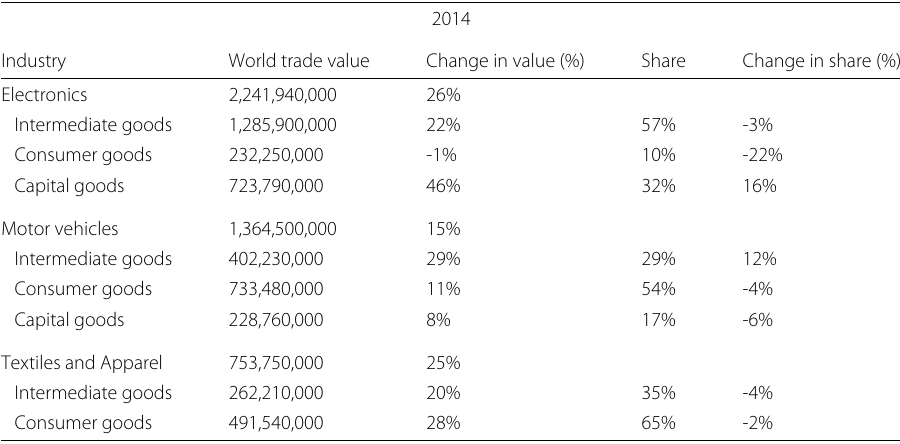
Table 2 USD values (current prices), share, and rate of variation of intermediate, consumer, and capital goods in the Electronics, Motor Vehicles, and Textiles and Apparel industries in